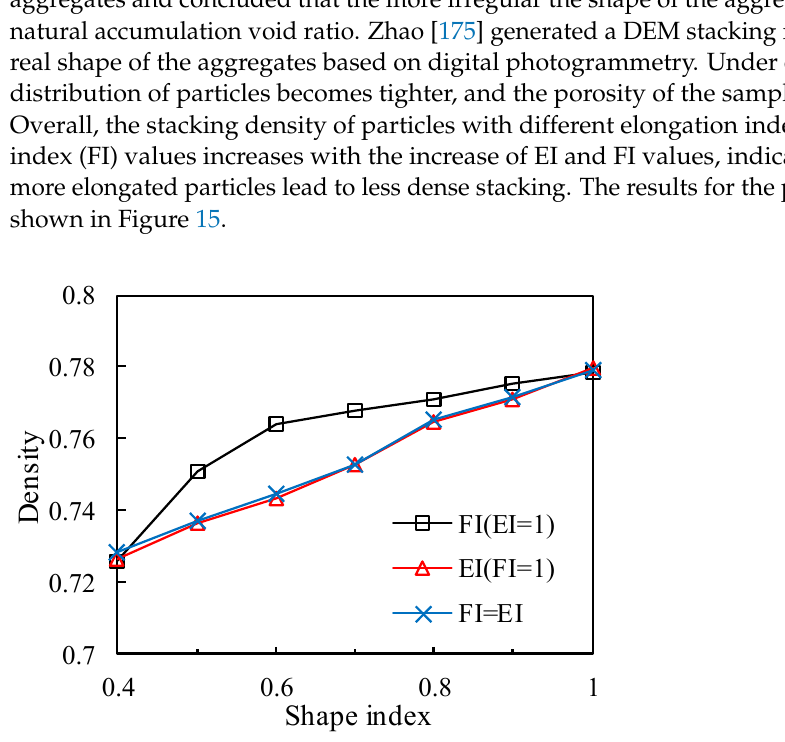
Figure 15. The results for the packing density.